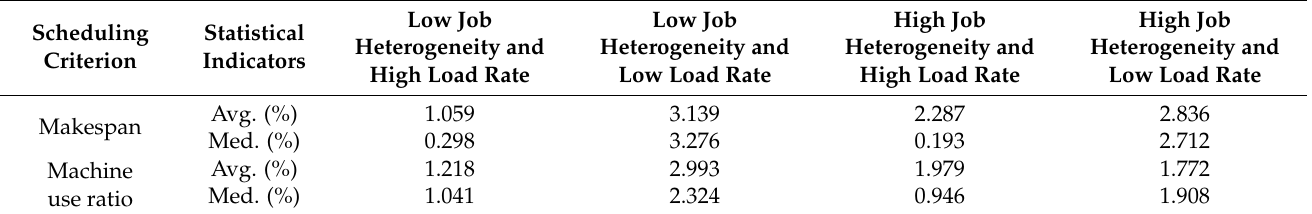
Table 11. Statistics of the comparison between the decision model and optimal DR combination